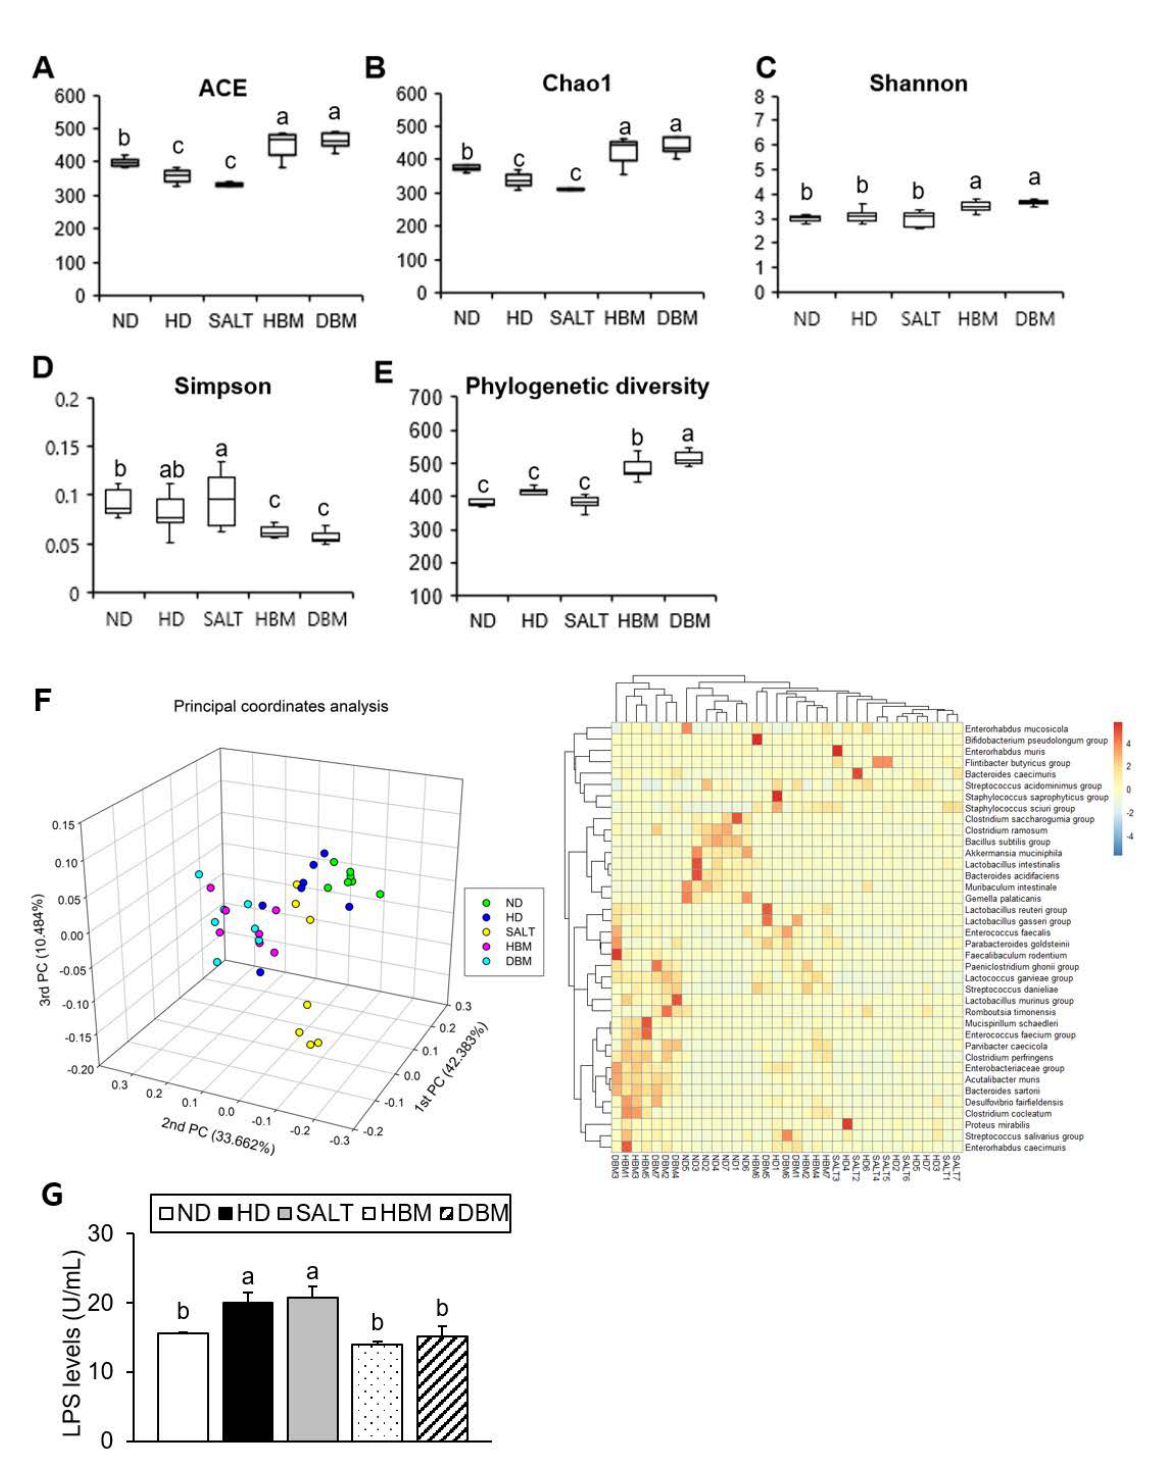
Figure 6. Effect of Gochujang on the relative abundance of gut microbial community in the HD-fed mice. ( A ) ACE; ( B ) Chao1; ( C ) Shannon entropy; ( D ) Simpson index; ( E ) Phylogenetic diversity; ( F ) 3D-Principal coordinate analysis (PCoA) and Heat map at species level; ( G ) LPS levels. Values are mean ± SEM. a–c means with the different letters on the bar ( p < 0.05). (a > b > c). ND, normal diet group; HD, high-fat diet group; SALT, HD with 0.7% salt group; HBM, HD with 10% of HBM Gochujang group; DBM, HD with 10% of DBM Gochujang